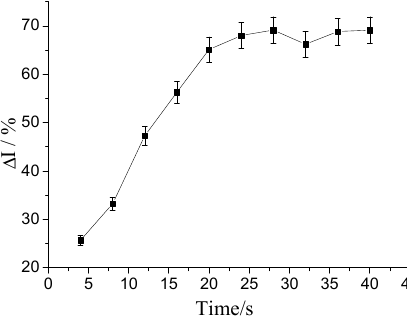
Figure 6. The effect of different binding times on the response of hFc γ Rn receptor biosensors. The detection times were 4 s, 8 s, 12 s, 16 s, 20 s, 24 s, 28 s, 32 s, 36 s, and 40 s.